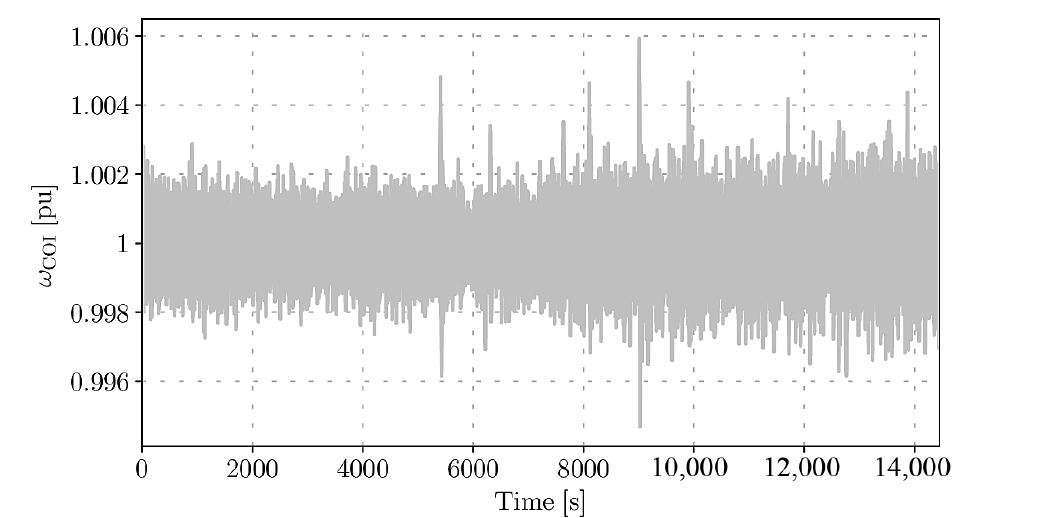
Figure 8. Trajectories of ω COI for 15-min time period and simplified